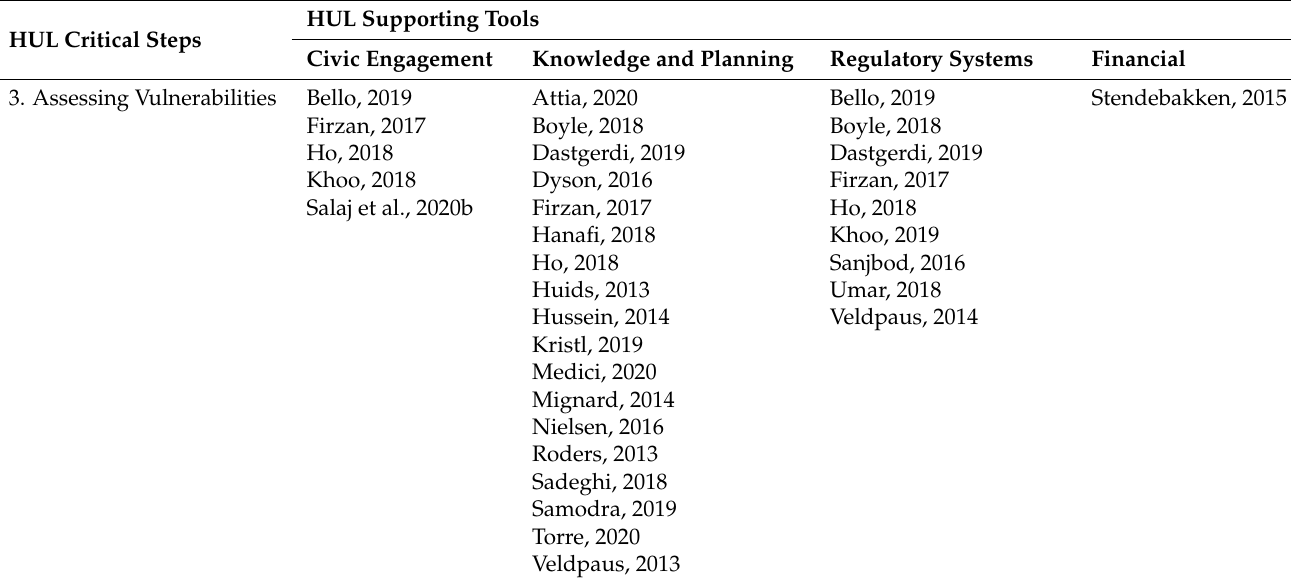
Table 3. List of authors discussing the assessing-vulnerabilities supporting tools of the HUL approach within the urban heritage facility management